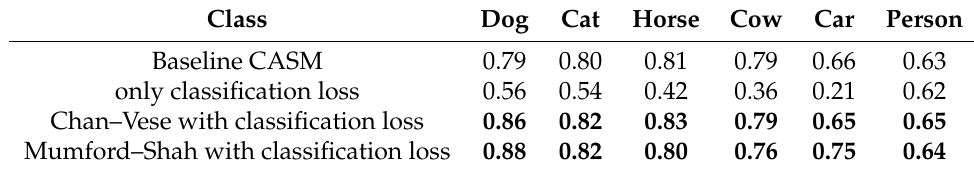
Table 1. Mean Intersection of Union of each class